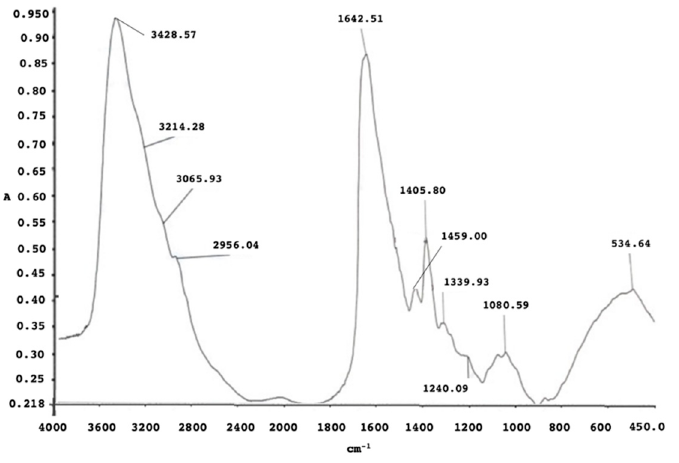
Figure 12. FT-IR spectrum of AgNPs produced by SAMU.